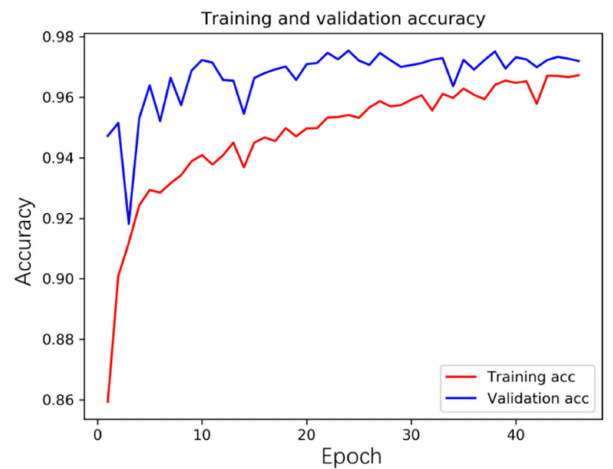
Figure 6. Training graph of RaftNet. The red line indicates the training accuracy and the blue line indicates the validation accuracy. The validation accuracy is higher than the training